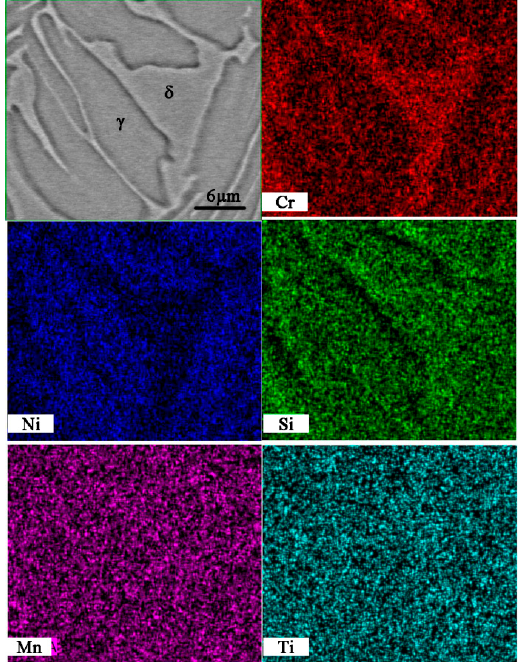
Figure 7. Element mapping of ferrite and austenite by energy dispersive spectroscopy (EDS) (online version in color).